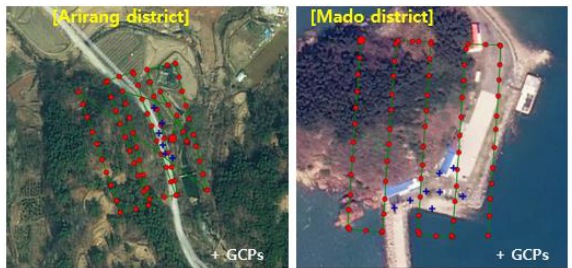
Figure 4. D rone flight path & Location of